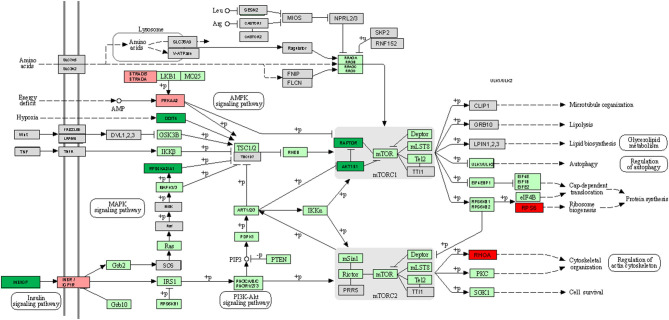
KEGG mTOR signaling pathway map comparing +AMR/+DSA and +DSA vs. –AMR/–DSA KT patients. Green color indicates up-regulated genes. Red color indicates down-regulated genes. The intensity of the color indicates the degree of gene regulation.